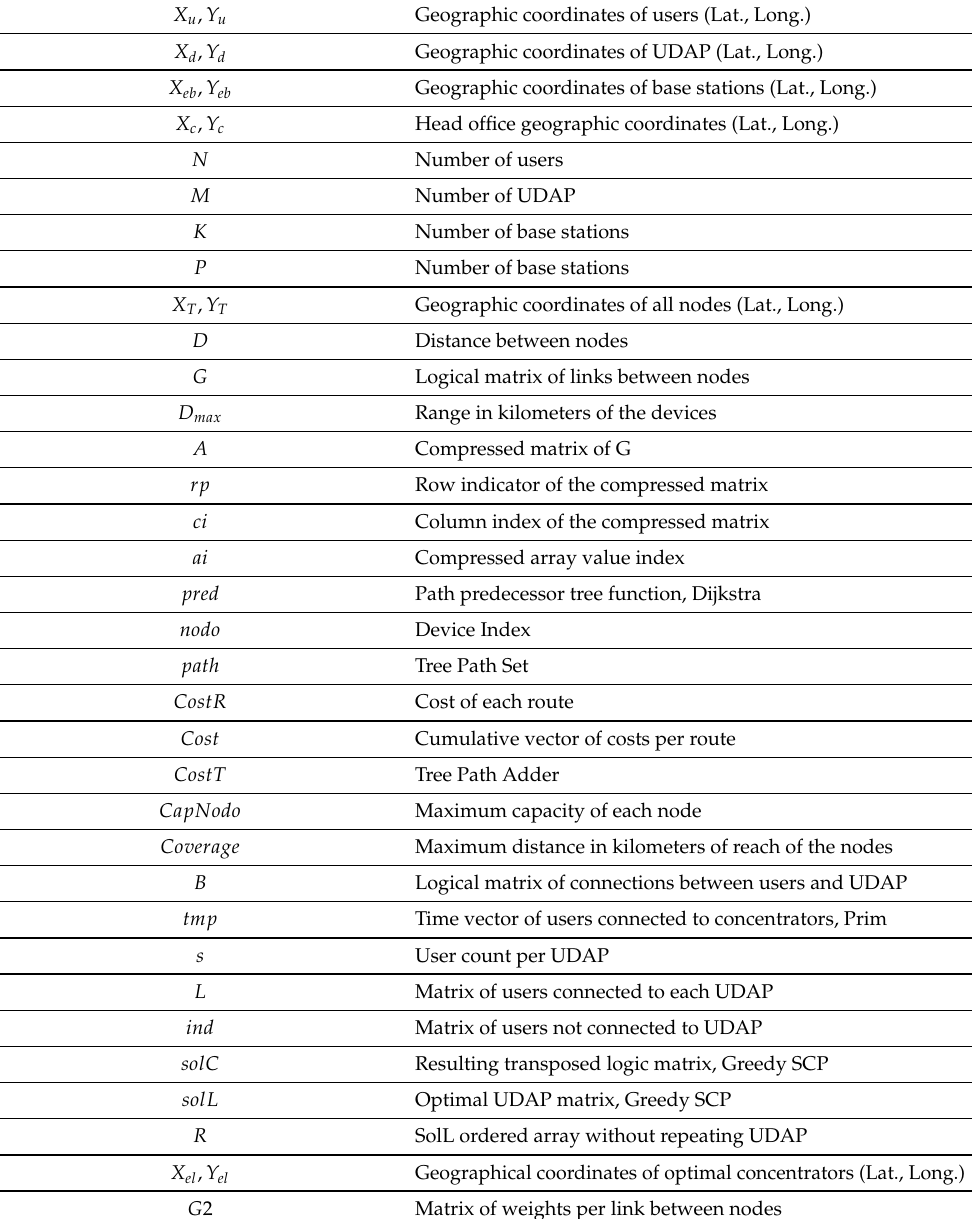
Table 3. Notation of model